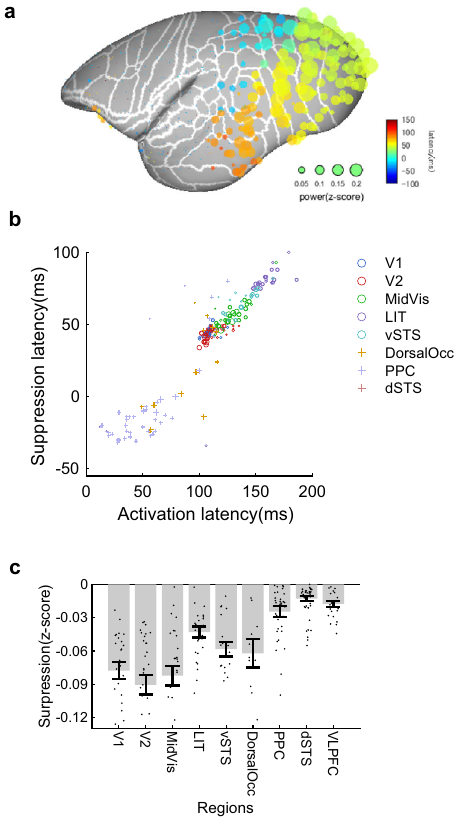
Fig. 3 Presaccadic suppression pattern of active vision. a Presaccadic suppression pattern across the whole lateral hemisphere from four animals. The size and color of the fi lled circles represent the magnitude and latency of the local minimum before saccade-evoked activation, respectively. The suppression magnitude of negative log P -values based on a randomization test is shown in Supplementary Fig. 1. b Correlation of activation and suppression timing across electrodes. Circles represent electrodes on the ventral stream, and the crosses are for the dorsal regions. A linear correlation can be seen between the latency of activation and suppression along the ventral stream. c Average suppression magnitude for each region. Error bars are the standard error of the mean. Dots show individual electrodes. The largest degree of suppression was observed across the entire ventral stream, and it was less prominent in the dorsal regions, except for the dorsal occipital